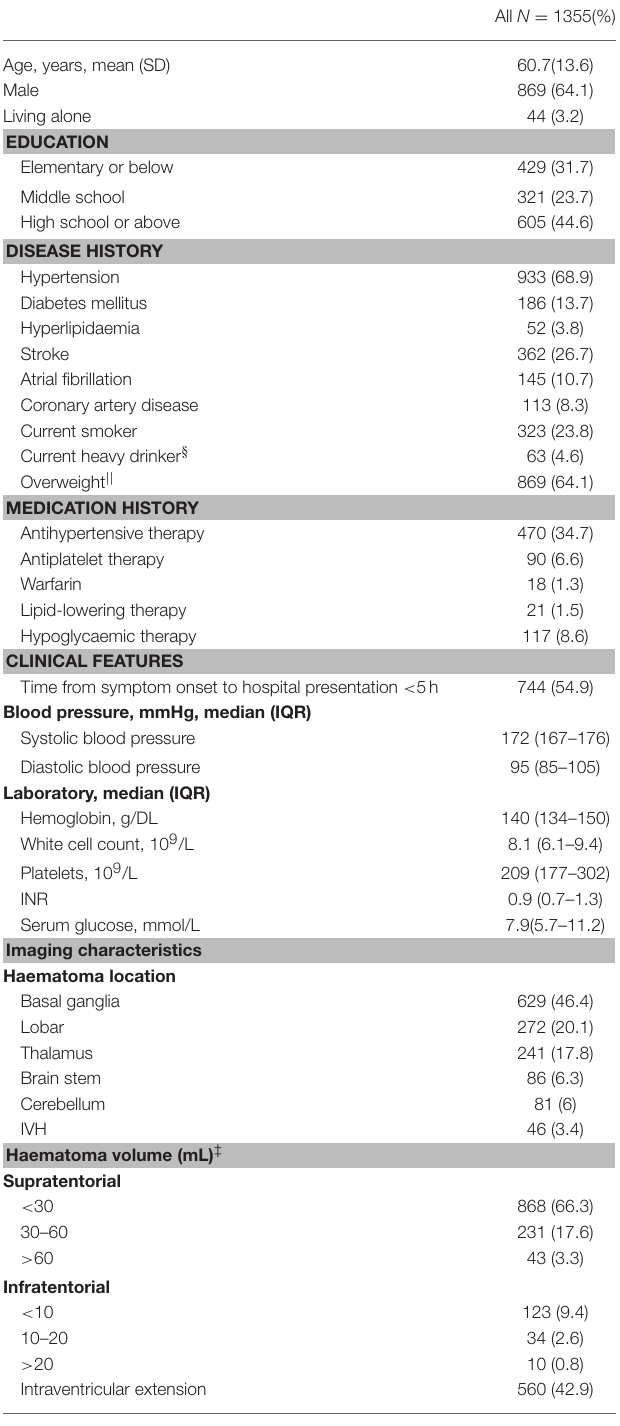
TABLE 1 | Characteristics of ICH